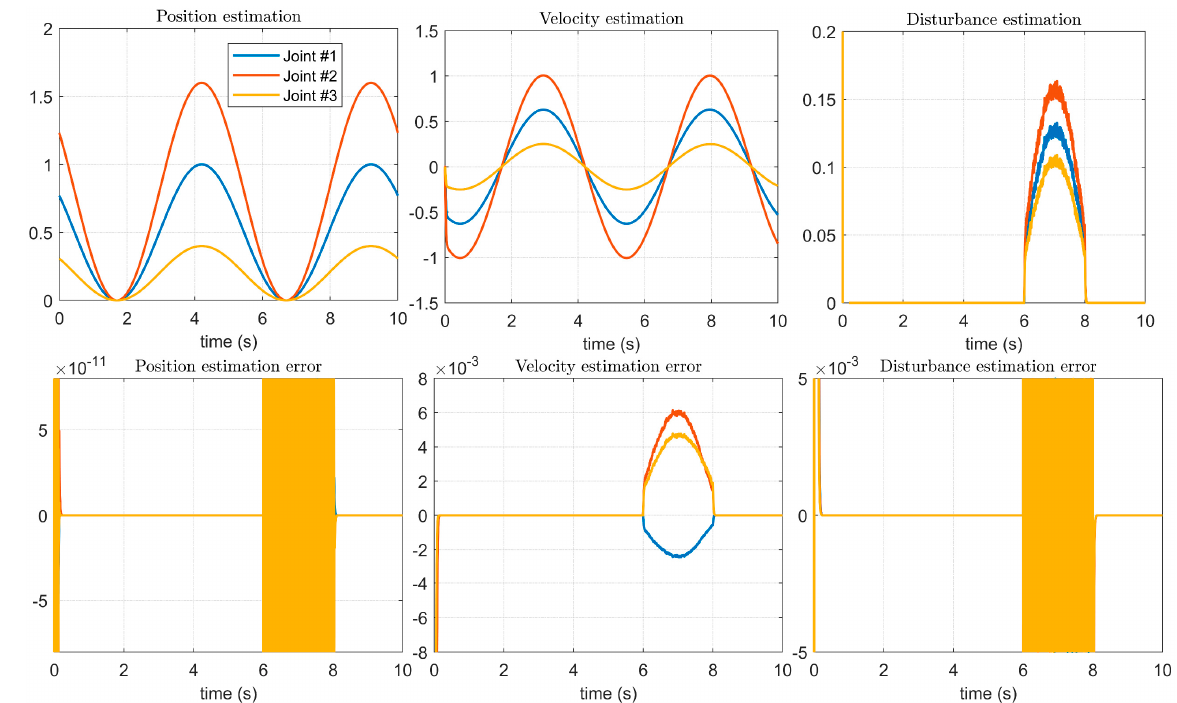
Figure 13. Estimation of control signals and disturbances with noise using the proposed method.